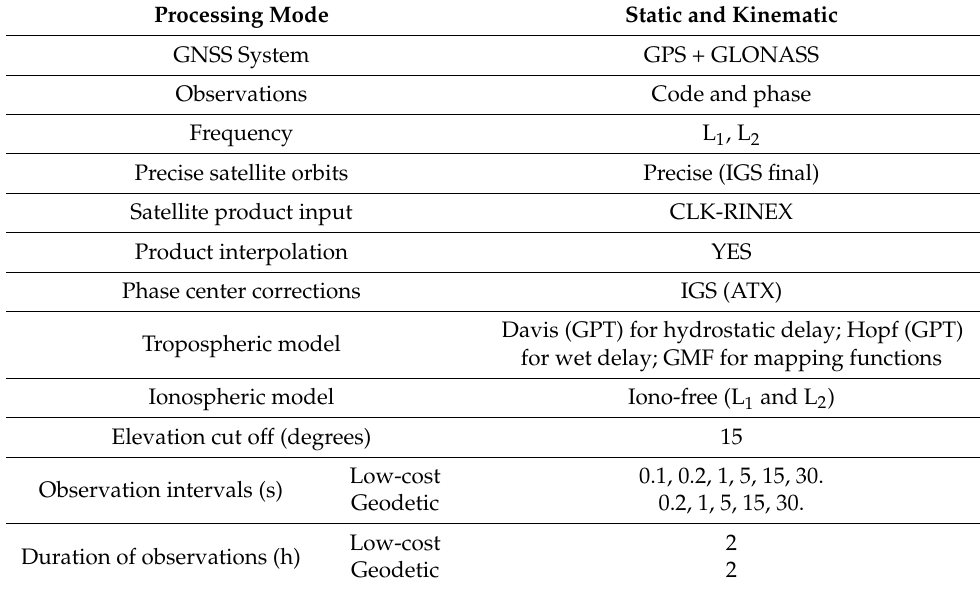
Table 1. Summary of processing options used by